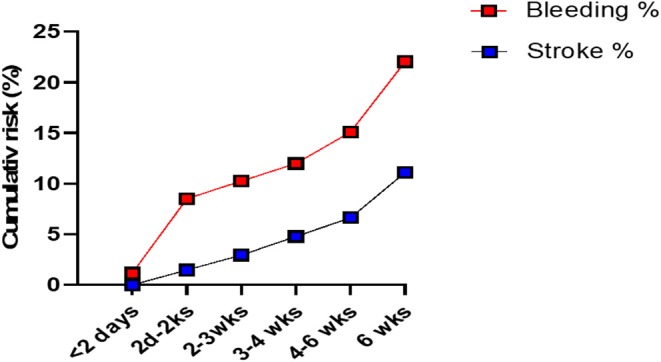
The cumulative risk of recurrence of the chronic SDH (“Bleeding”) and that of stroke in patients with cSDH (all patients combined). The cumulative risk of recurrence increases with time. There are 2 periods of higher risk (dramatic increase in the curve) at 2 days to 2 weeks post-op and after 6 weeks post-op. The risk of stroke gradually increases with time.